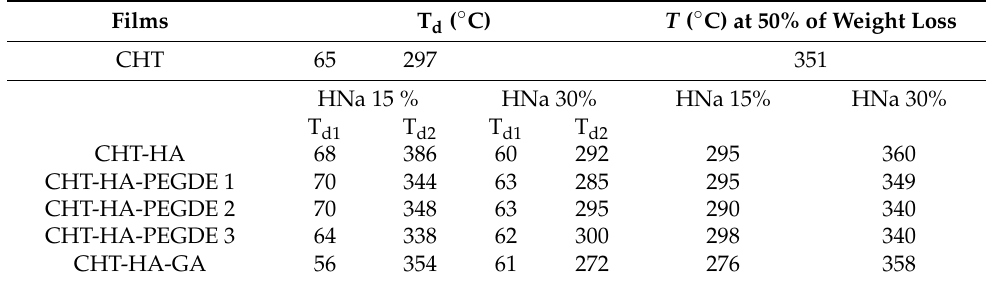
Table 2. Decomposition temperatures and weight loss of CHT films, CHT/HNa at 15% and 30% films crosslinked with GA and PEGDE.